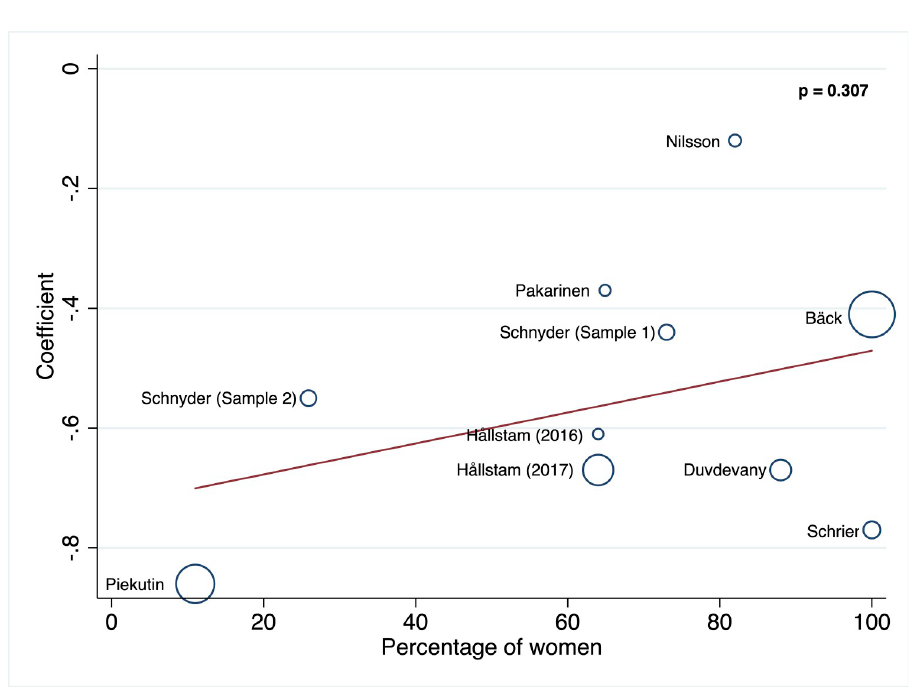
Fig 4. Random-effects meta-regression models for the association between SOC and depression in gender.